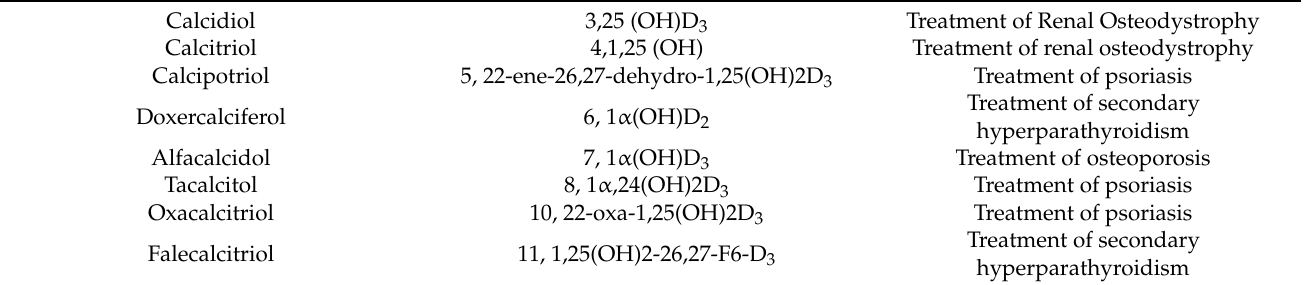
Table 1. Derivates of vitamin D with clinical